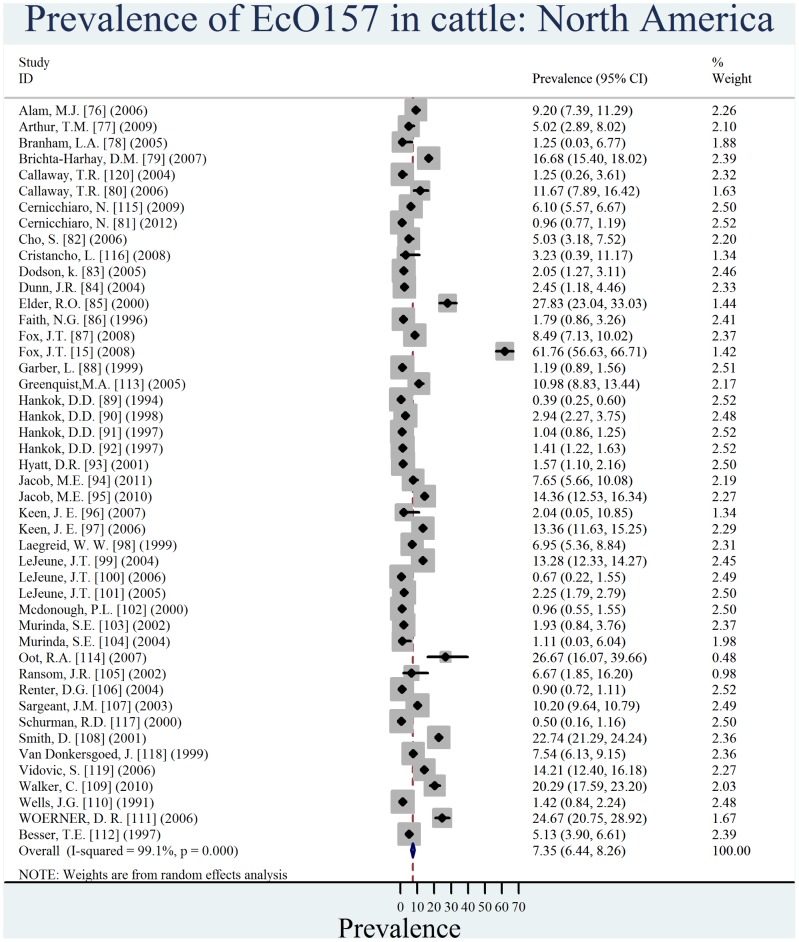
Forest plot of prevalence of E. coli O157 in cattle amongst studies conducted in North America.